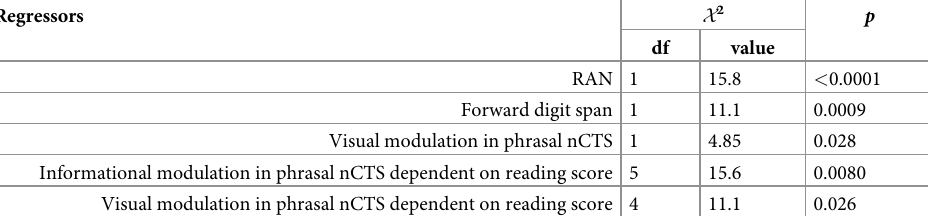
Table 3. Regressors included in the final linear mixed-effects model fit to the five reading scores (dependent vari- ables). Regressors are listed in their order of inclusion.